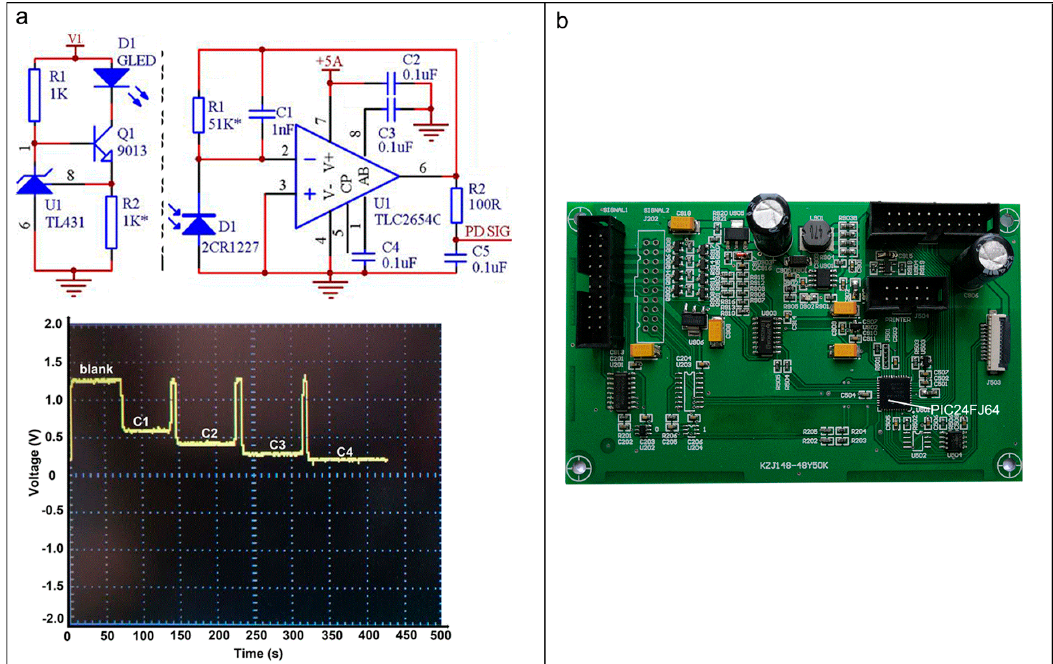
Figure 2. The circuits of the multichannel optoelectronic measurement system. ( a ) The diagram of the constant current source circuit with a three-terminal adjustable shunt regulator for driving LED, the front-end circuit of an impedance amplifier for the photodiode and the responding output voltages of the circuits displayed on the oscilloscope. ( b ) The prototype of the microcontroller unit (MCU) circuit board, including a chip of PIC24FJ64, a 16-bit A/D converter ADS1100, and a multiple switcher